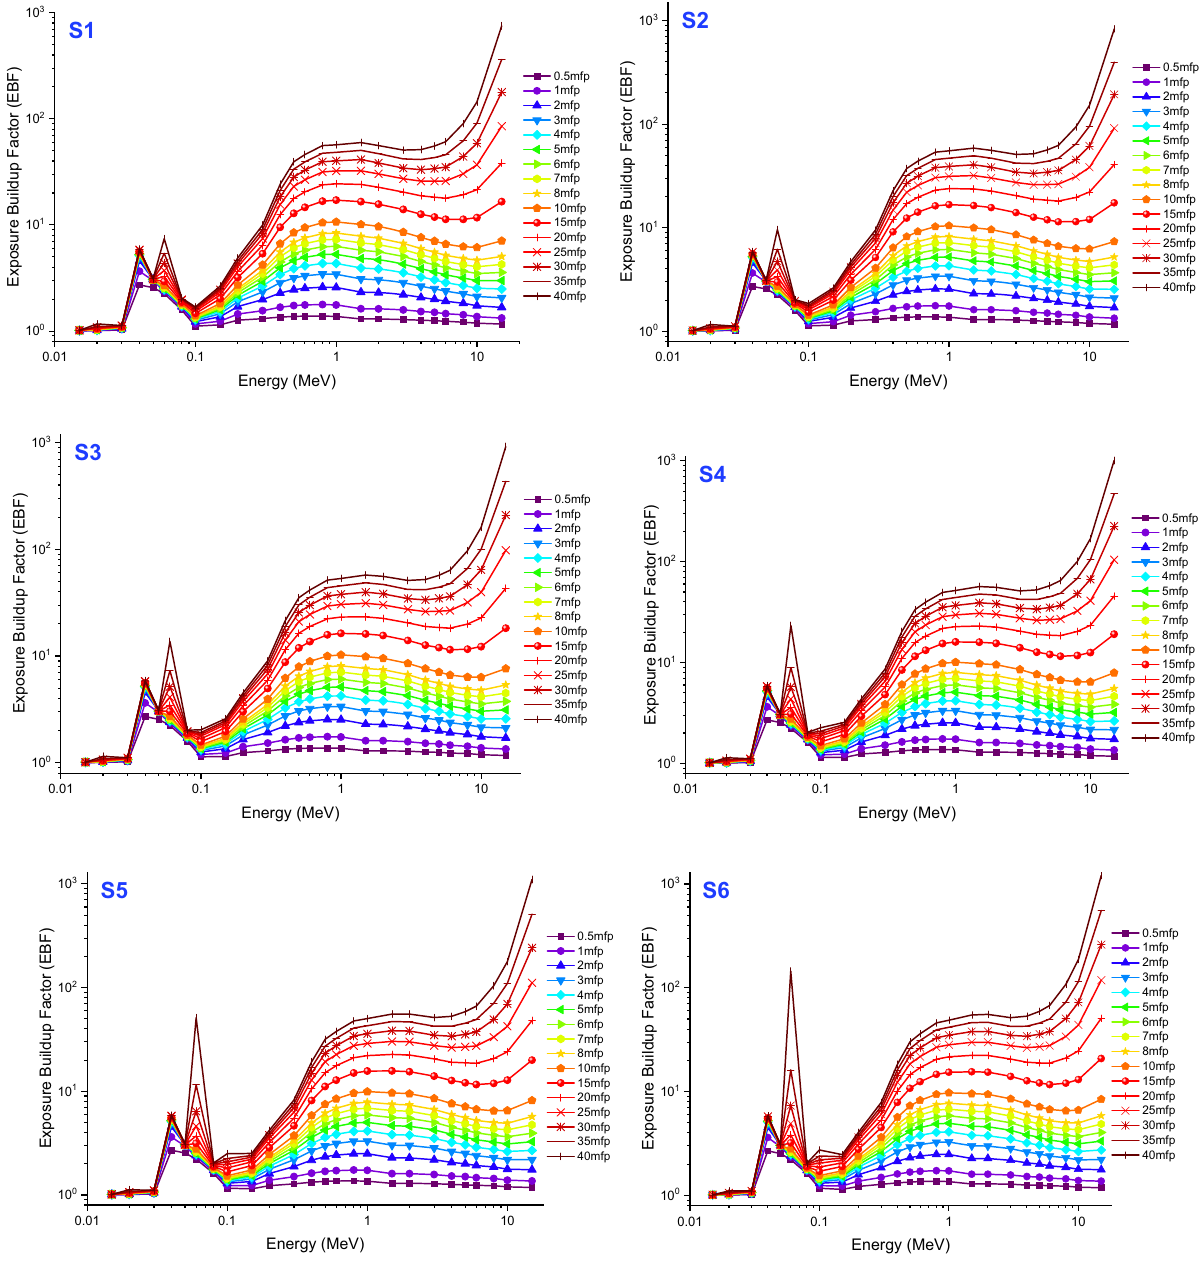
Figure 5: Variation of EBF of investigated glasses at di ff erent mean free path